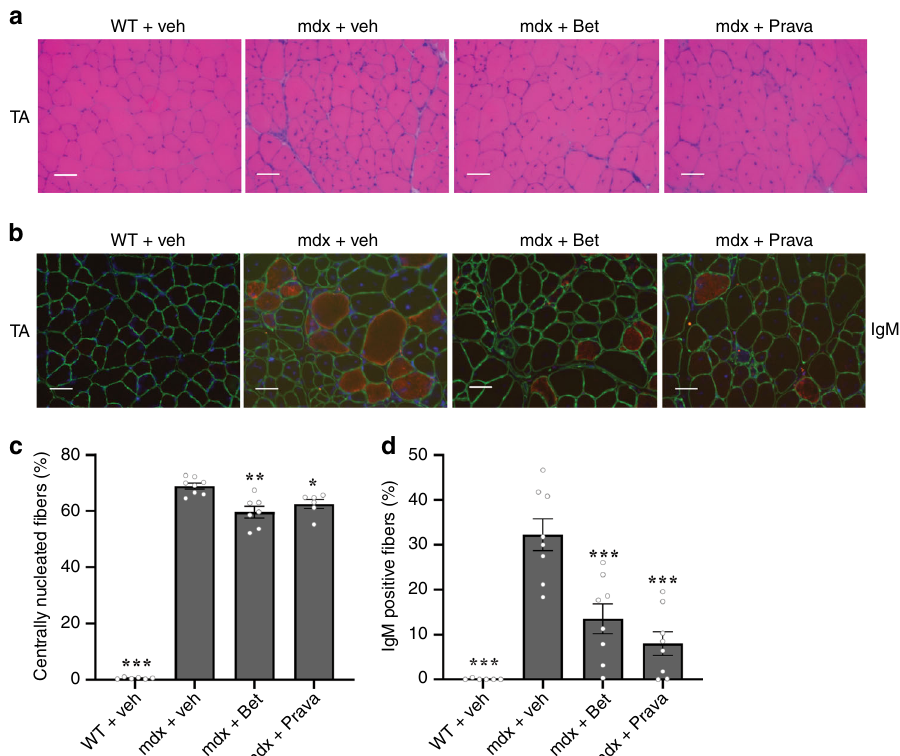
Fig. 6 Morphological features of mdx muscle fi bers treated with Betaxolol and Pravastatin. a Representative examples of cross-sections of TA muscles from wild-type (WT) and mdx mice treated with Betaxolol (Bet), Pravastatin (Prava) or with vehicle (saline) that were stained using hematoxylin and eosin. b Representative examples of cross-sections of TA muscles from WT mice and mdx mice treated with Bet, Prava or vehicle that were immunostained with goat-anti-mouse IgM Alexa 594. c Percentage of central nucleation in TA muscle fi bers. d Quanti fi cation of IgM positive fi bers vs total muscle fi bers. N = 6 for WT and N = 8 for mdx + veh or treated. Error bars represent SEM, * P < 0.05, ** P < 0.01, *** P < 0.001, signi fi cantly different from mdx vehicle control. Scale bars, 50 mm. One-way ANOVA and Bonferroni post-hoc test was performed to determine statistical differences. Source Data for c and d are provided in the Source Data